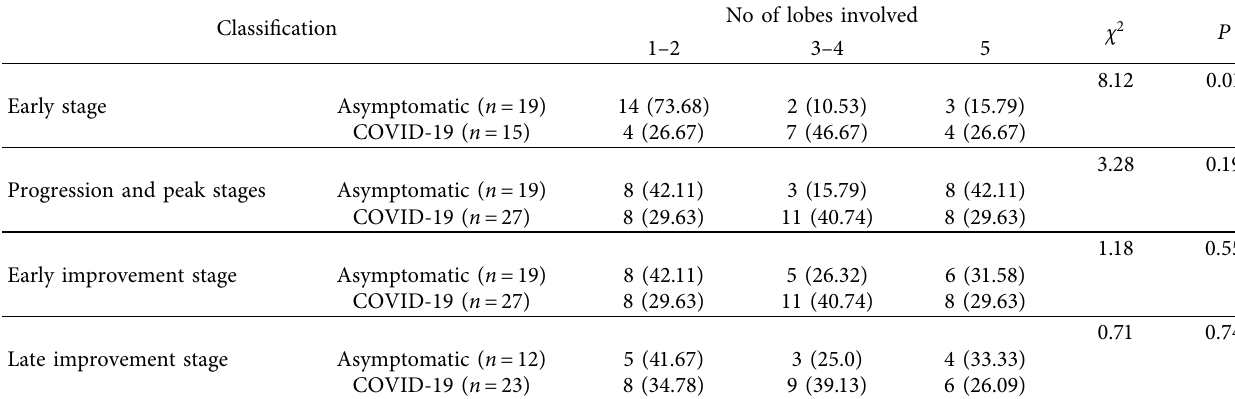
Table 2: Pulmonary lobes involved by lesions [ n